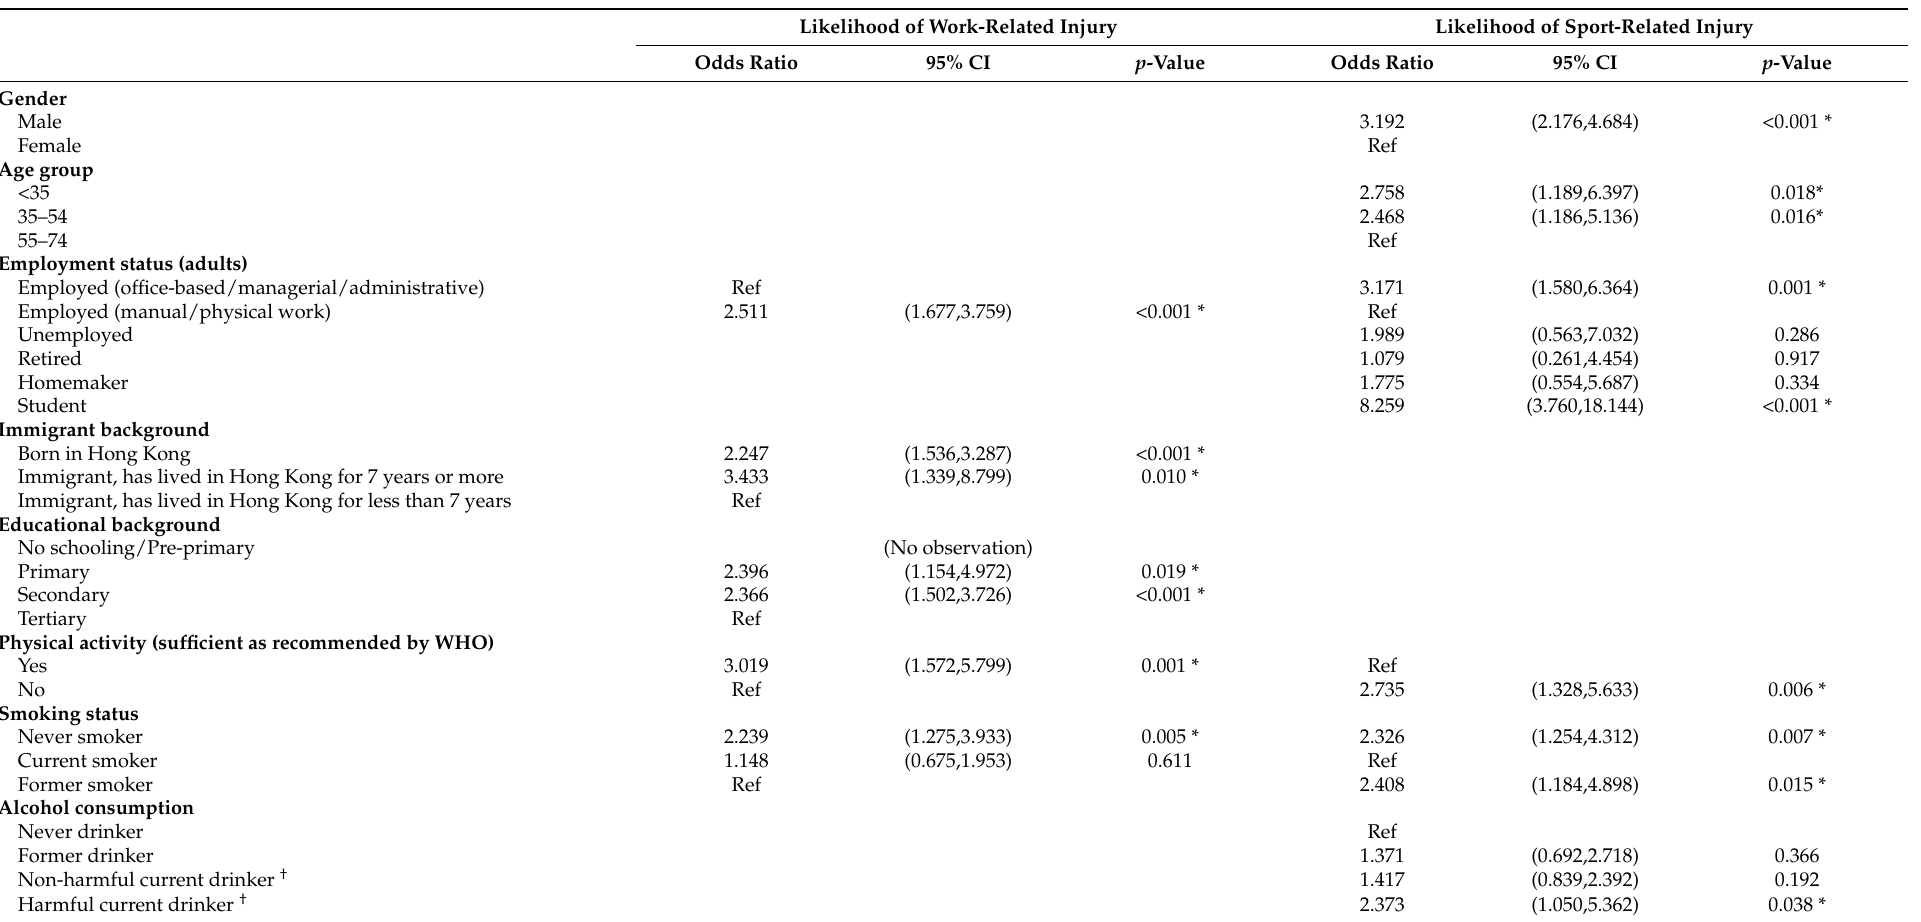
Table 5. Multivariable logistic regression analysis of factors associated with work-related and sport-related unintentional injury as the most severe unintentional injury episode. Likelihood of Work-Related